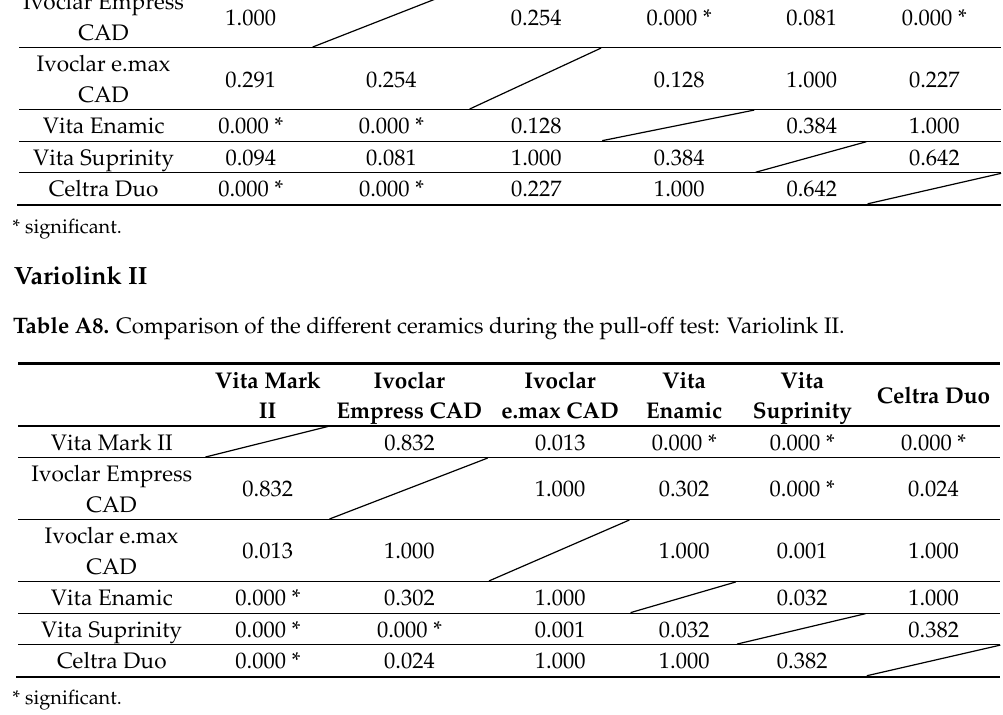
Table A9. Comparison of the different ceramics during the pull-off test: RelyX Unicem.